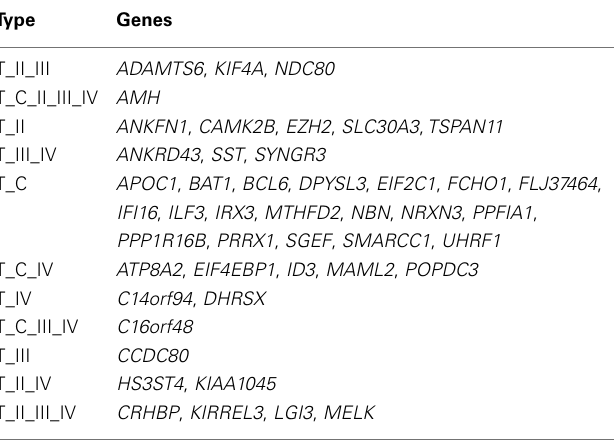
Table 5 | List SKGs of glioma.